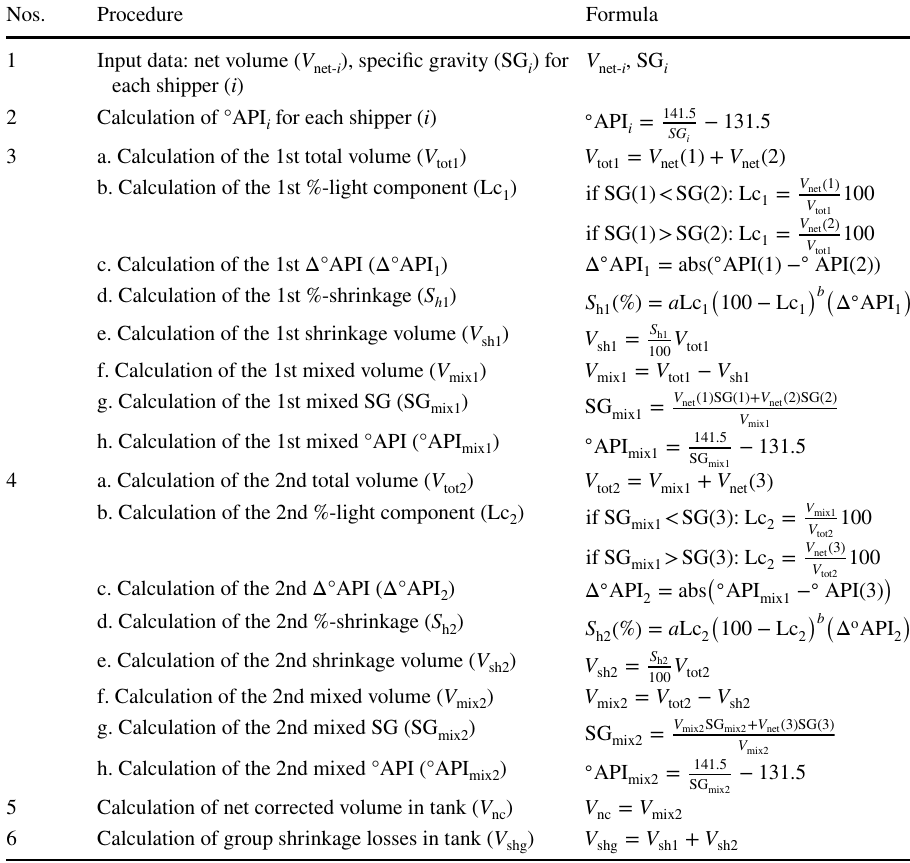
Table 9 Calculation procedure of shrinkage volume in tanks